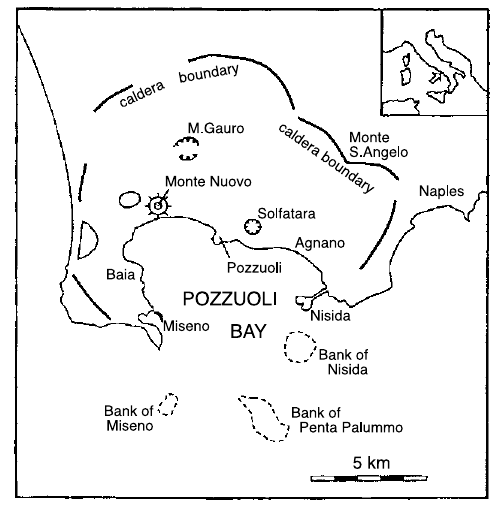
Fig. 1. Topographic sketch map of Campi Flegrei (after Dvorak and Gasparini,